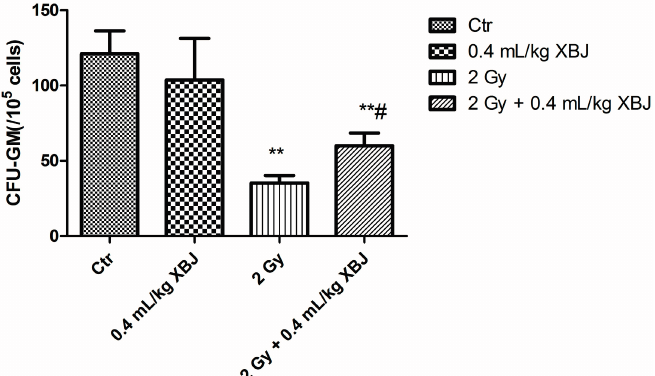
Figure 3. The ability of BMMNCs to form colonies, which was decreased by IR, was increased by XBJ administration. Mice were treated by i.p. injection of vehicle or XBJ after exposure to 2 Gy TBI. A group of sham-irradiated control mice was included as a control (Ctr) and XBJ. BMMNCs were collected from the mice nine days after 2 Gy TBI and cultured in MethoCult GF M3534 methylcellulose medium for CFU-GM analysis. The results are expressed as the number of CFU-GM per 10 5 cells and are presented as